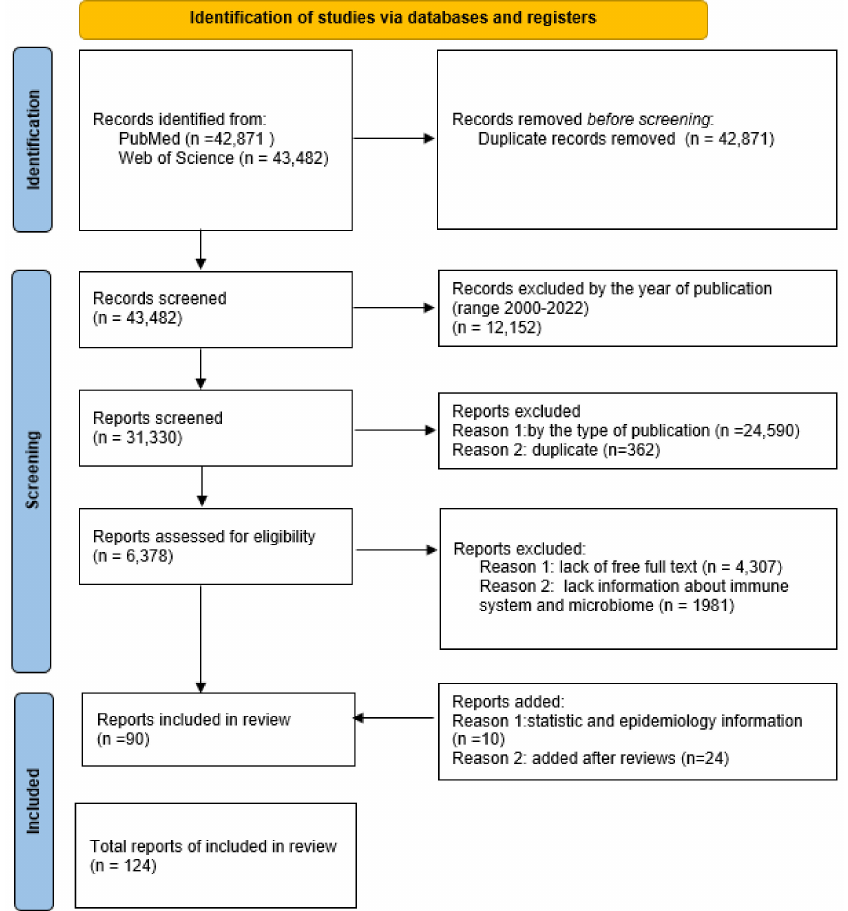
Figure 2. The flow diagram of the study’s inclusion and exclusion